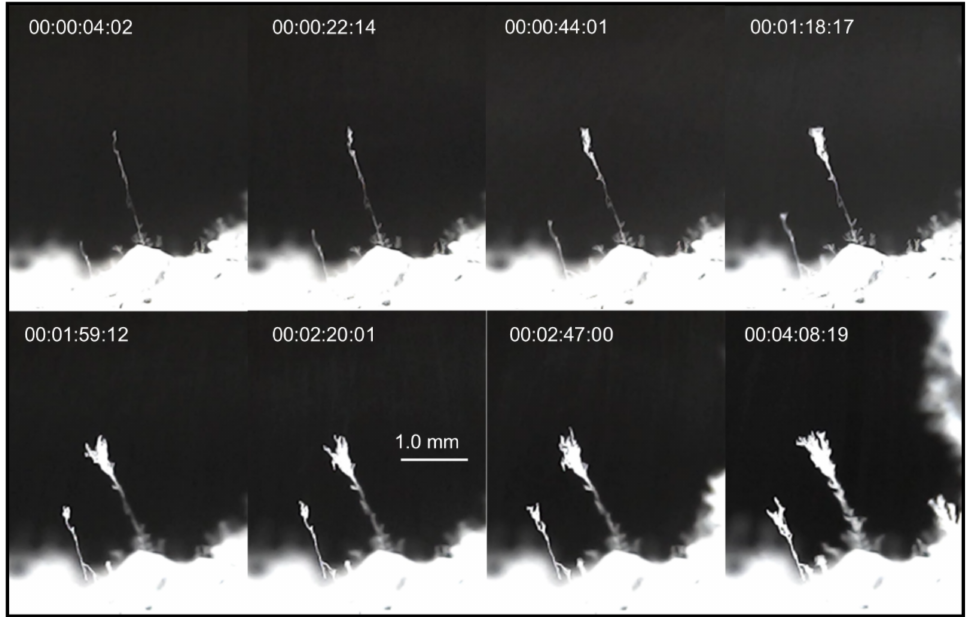
Figure 7. Frame series shows dendrite growth on the top and around isolated needles. Needles show only the non-uniform radial growth (presented in detail in Figures 4 and 5) for tens of seconds until their tops grow. The enlarged needle tops are the sites for the multiple branching in the later pictures. Short branches also bud along the lower sections of the needles, and their number increases, but not the